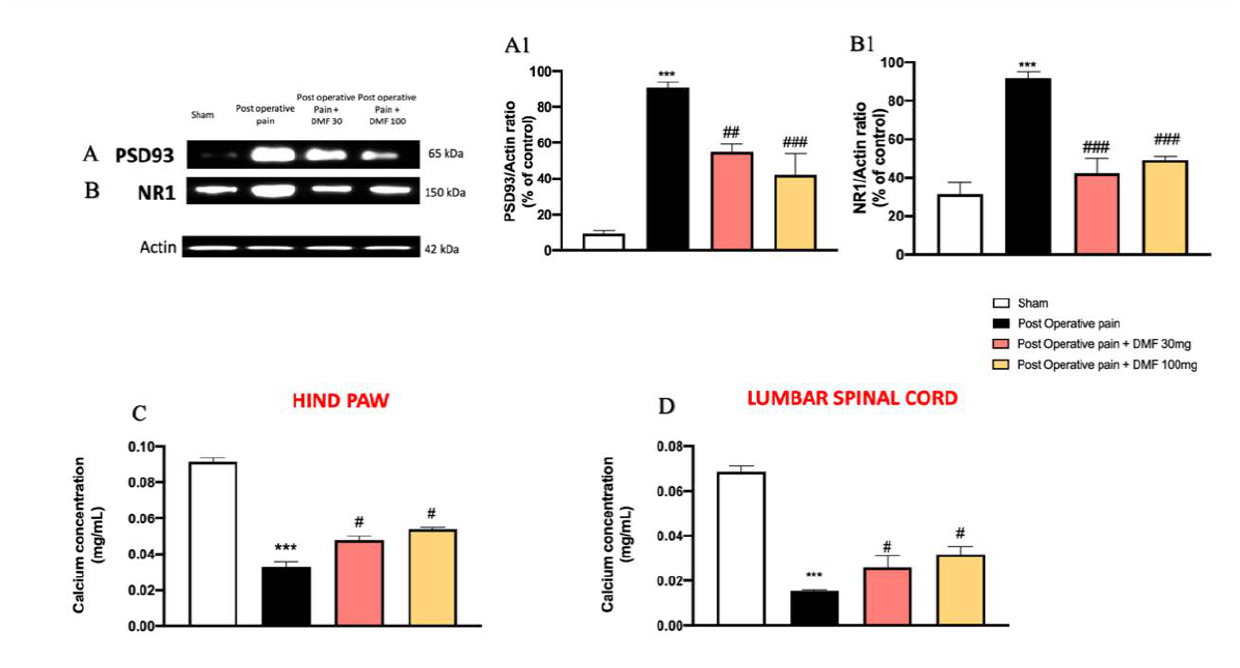
Figure 7. DMF treatment modulated NMDA-receptor-operated calcium channels. Western blot analysis on hind paw samples of cytosolic PSD93 ( A , A1 ) and NR1 expression ( B , B1 ). ELISA kit for calcium concentration on hind paw tissue ( C ) and lumbar spinal cord tissue ( D ). A p -value of less than 0.05 was considered significant; *** p < 0.001 vs. sham, ### p < 0.001, ## p < 0.01, # p < 0.05 vs. PO